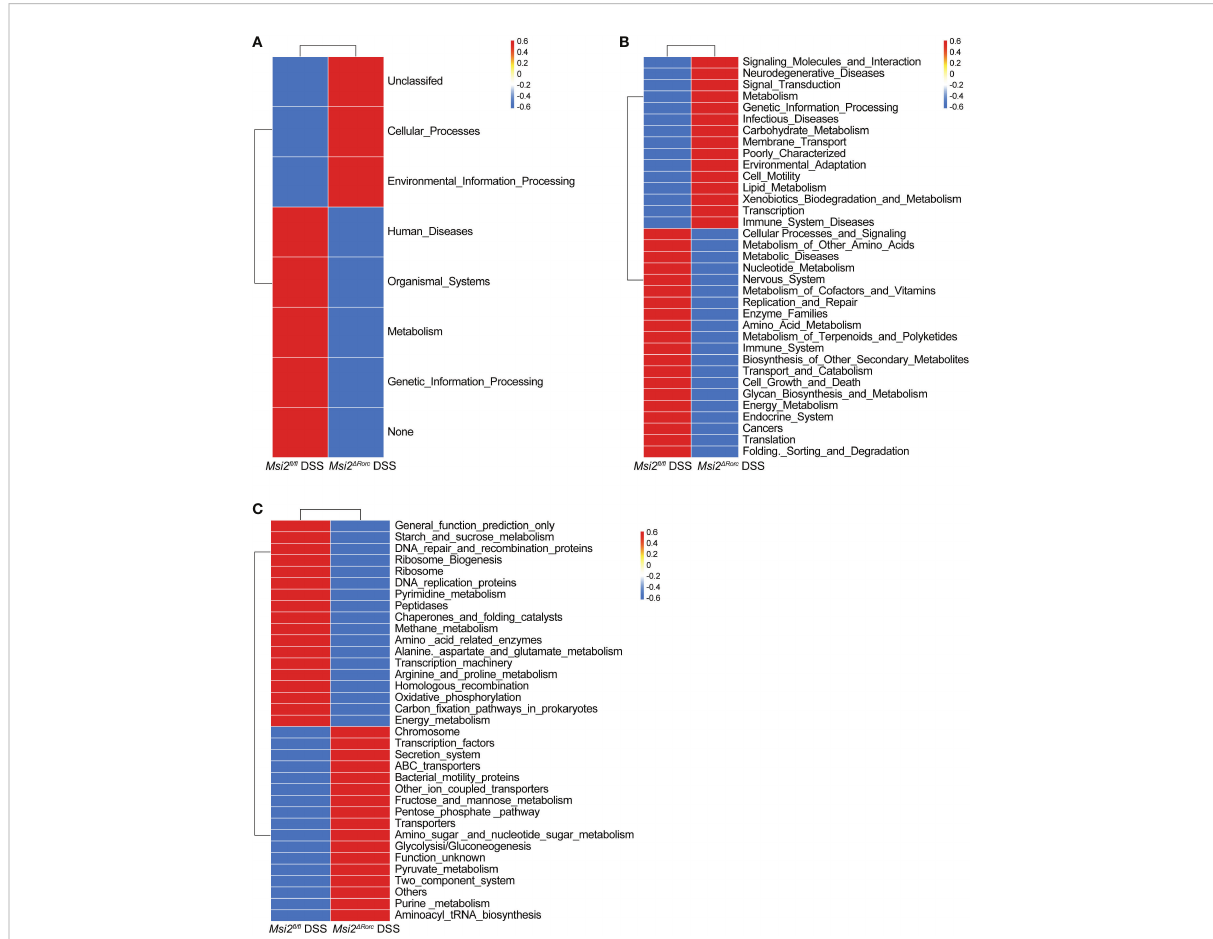
FIGURE 9 Prediction of the changes in intestinal microbiota function between the two groups. (A – C) Heatmap of the changes predicted in intestinal microbiota function between the Msi2 fl / fl DSS group and the Msi2 D Rorc DSS group in the KEGG pathway analysis at levels 1, 2, and 3 (A-Level 1, B-Level 2, and C-Level 3)